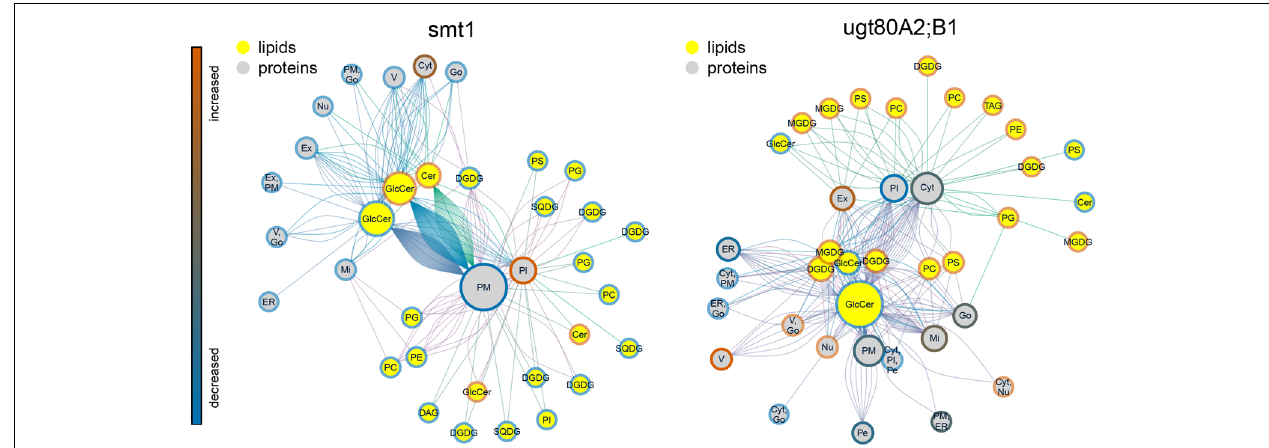
FIGURE 4 | Lipid–protein correlation network displaying proteins according to subcellular localization in SUBA3 (Tanz et al., 2013). Edges were selected for significance using a false discovery threshold lower 1%. For both mutants glycosylceramide shows the highest degree indicated by node diameter. In particular an inverse relationship of increased (blue node frame) ceramides and plasma membrane proteins is visible for smt1 , while in ugt80A2;B1 more sterol-dependent proteins correlated with decreased (red node frame) levels of glycosylceramides. In general, lipid–protein connections were grouped by their subcellular